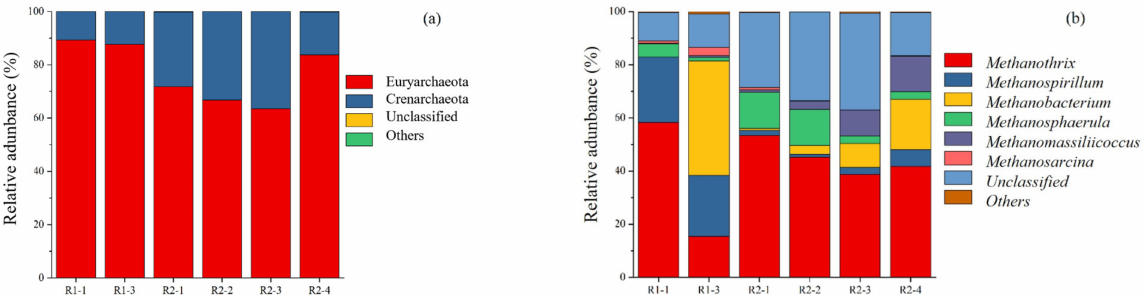
Figure 4. Variation of archaeal community structure; ( a ) Percent of archaeal community abundance at phylum level; ( b ) Percent of archaeal community abundance at genus